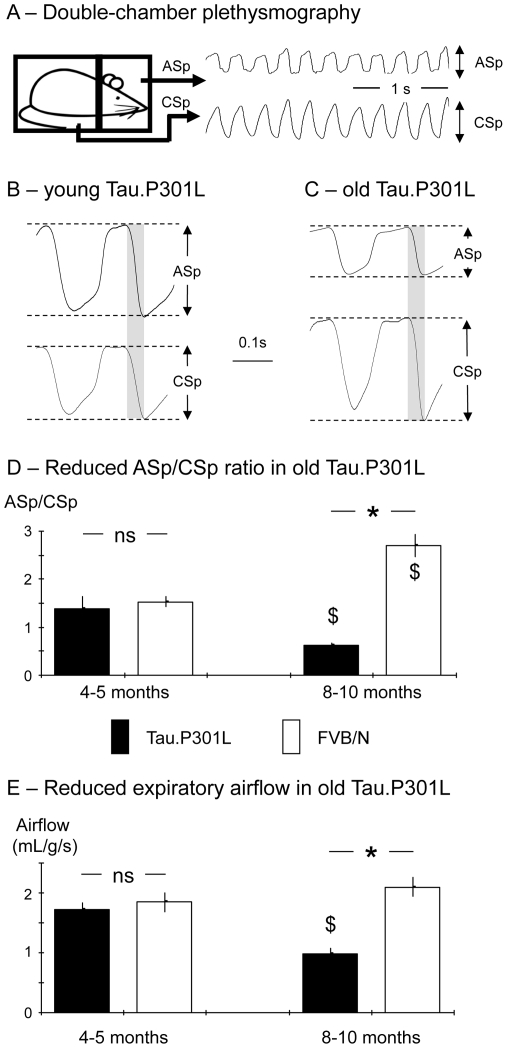
Reduced expiratory airflow in old Tau.P301L mice.A - Schematic presentation of the double-chamber plethysmographic set-up allowing the simultaneous recordings of chest spirogram (CSp; in the body chamber) and airflow spirogram (ASp; in the head chamber) in conscious mice. B, C – Averaging of about 100 successive respiratory cycles during quiet period of breathing in young (B) and old (C) mice allowed the measurements of mean ASp and CSp, the calculation of the ASp/CSp ratio and the measurement of expiratory airflow during lung emptying period (gray areas). D - Columns in histograms show the ASp/CSp ratio in Tau.P301L (black columns) and FVB/N (white columns) young and old mice. Note 1) the ratio was similar in young Tau.P301L and FVB/N mice, and 2) the ratio was significantly reduced and increased in old Tau.P301L and FVB/N mice, respectively. E – As in D but for the expiratory airflow. Note the expiratory airflow was similar in young Tau.P301L and FVB/N mice, significantly halved in old Tau.P301L mice and unchanged in old FVB/N mice. * indicates a significant inter-strain difference at a given class of age and $ a significant age-related difference for a given strain; ns, non significant inter-strain difference.